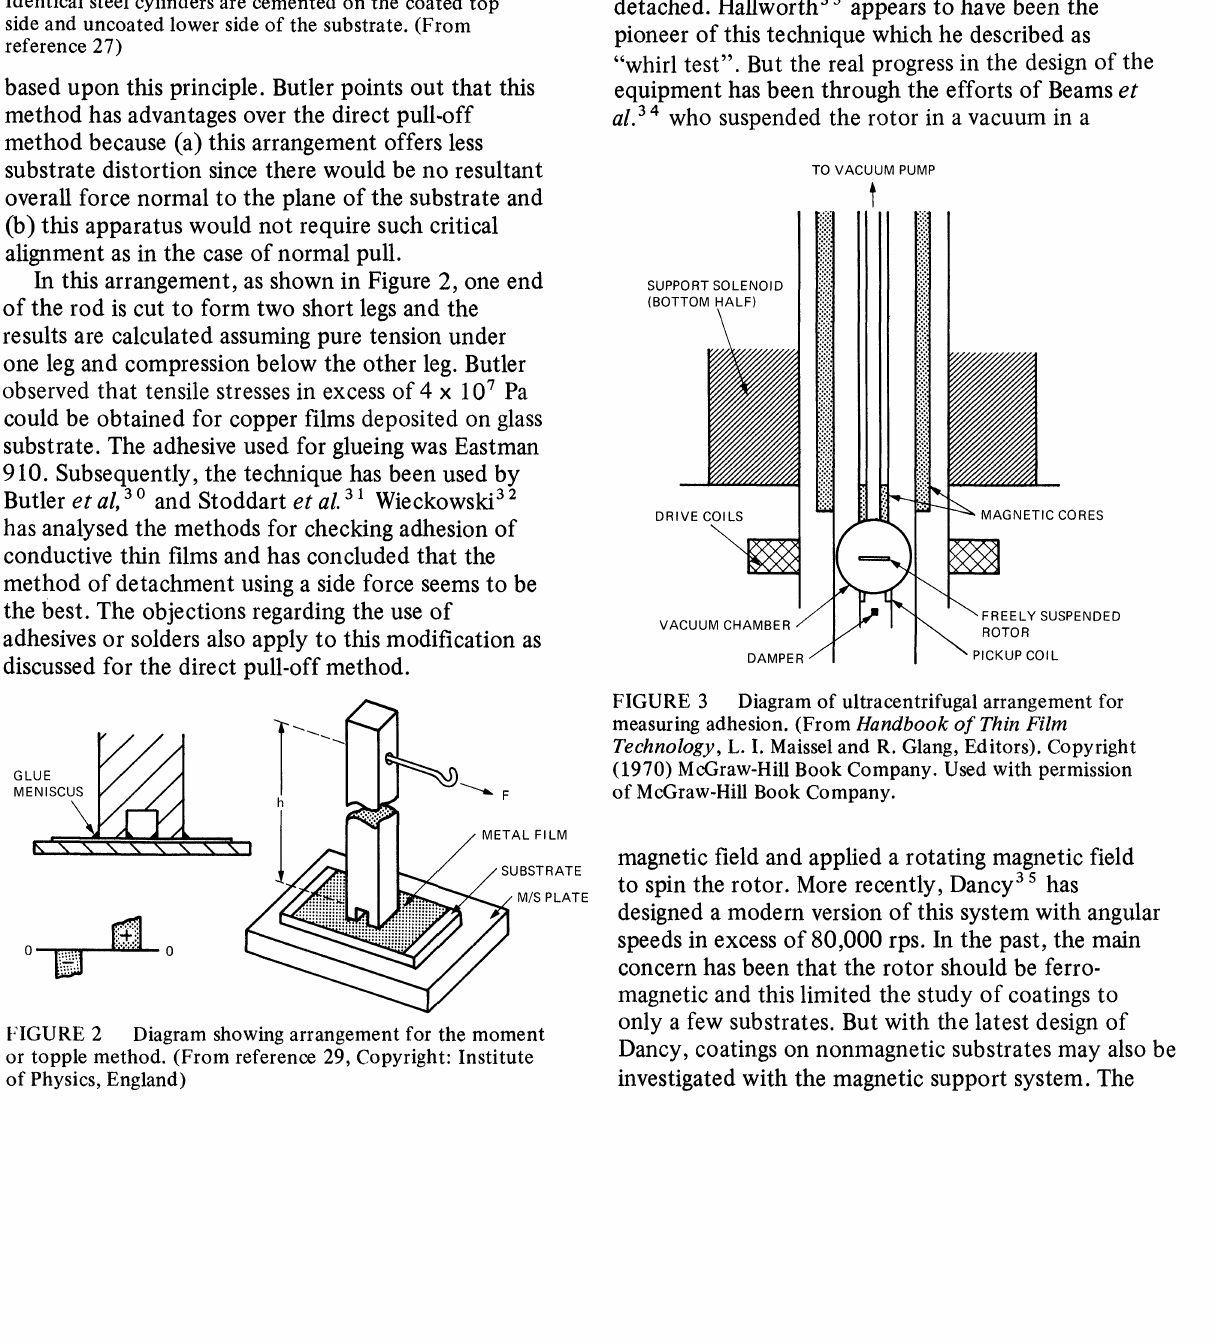
Diagram showing arrangement for the moment or topple method. (From reference 29, Copyright: Institute of Physics, England)